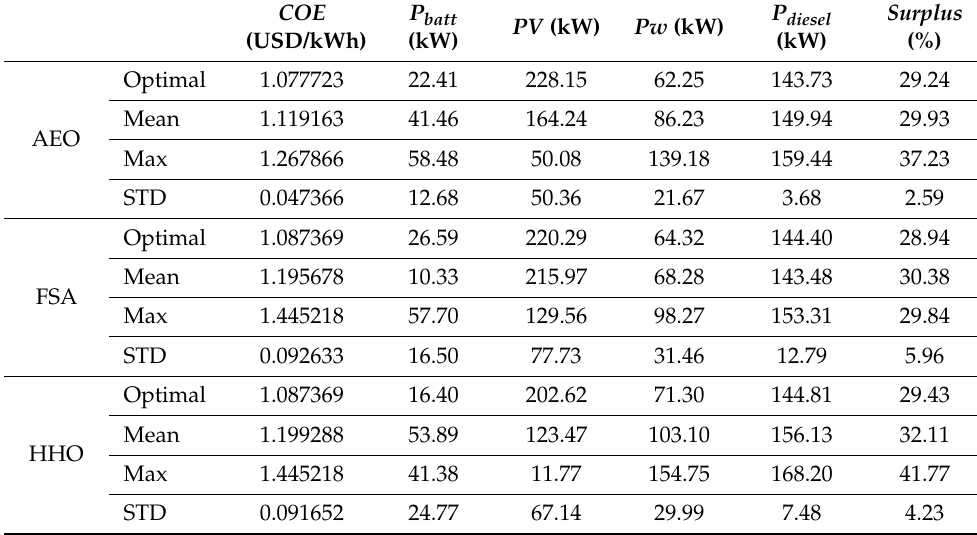
Table 5. Optimal, Minimum, Maximum, and STD for AEO, FSA, and HHO with DSM at 40% REF and 0% LPSP.